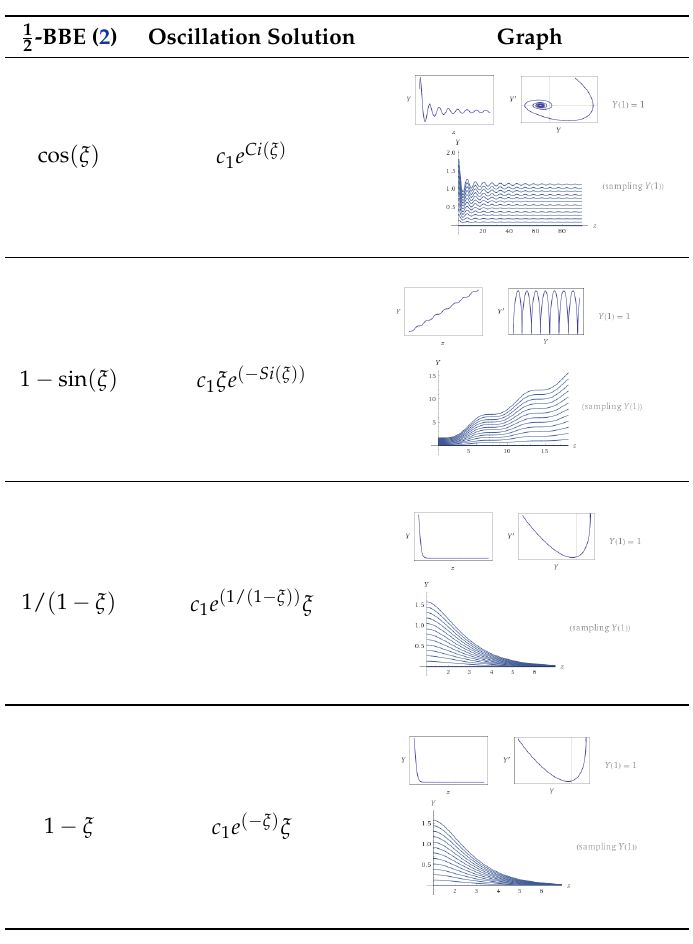
Table 2. The oscillation solution for different Υ ( ξ )